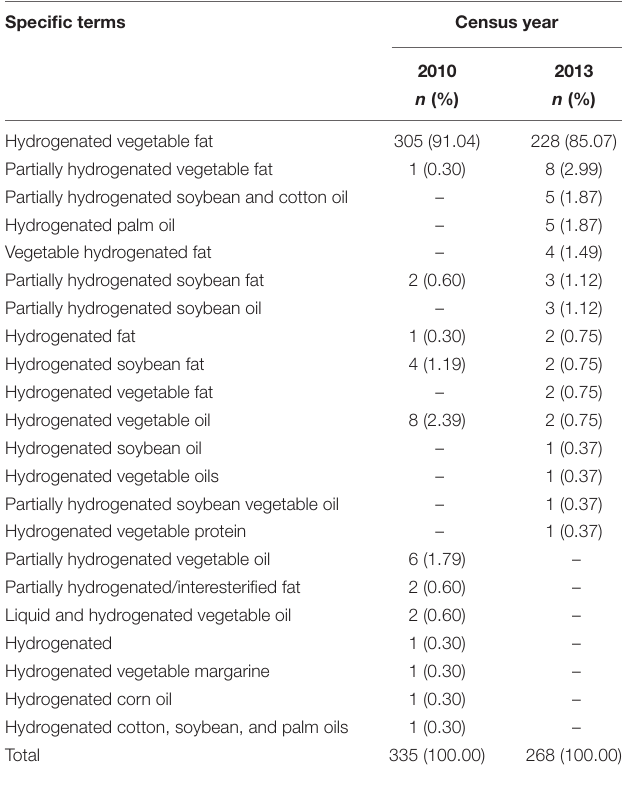
TABLE 2 | Specific terms for sources of industrially produced trans-fat acids and their frequency of occurrence on the ingredients list of packaged foods sold in Brazilian supermarkets, as assessed by the food label census method in 2010 and